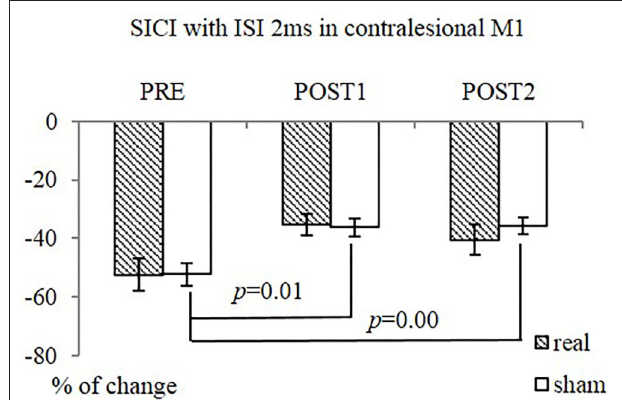
FIGURE 5 | SICI (ISI 2ms) in contralesional M1 in both groups. The sham-tDCS group ( n = 9) had significantly reduced SICI 2ms at POST1 and POST2, compared PRE. No difference over time was observed in real-tDCS group ( n = 10). Between-group difference was not significant.